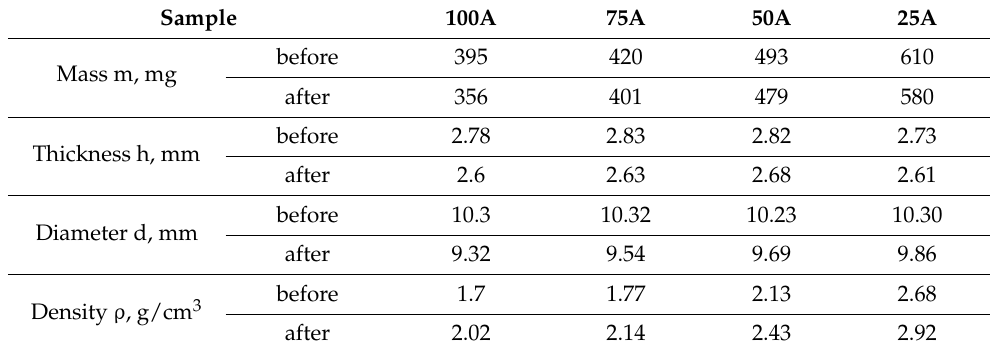
Figure 4. Contents of O, Al, and Cr in the cross sections of 75А, 50А, and 25А composites. Composite parameters before and after electron-beam sintering are shown in Table 3. Table 3. Composite parameters before and after sintering.